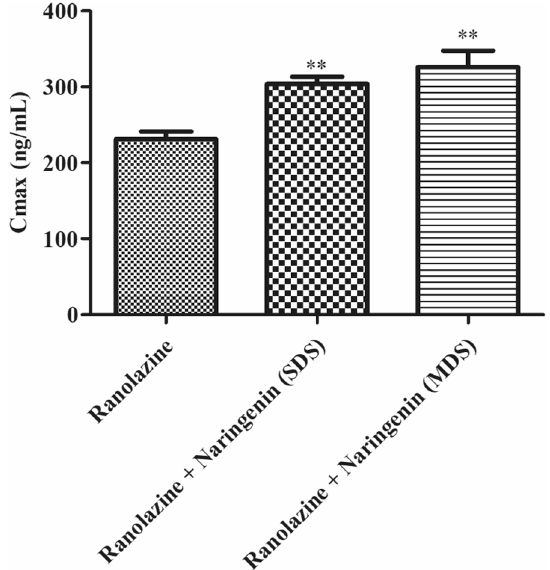
Fig. 3 Area under the curve of ranolazine alone and when naringenin was present in SDS and MDS ( n study; MDS, multi-dose study